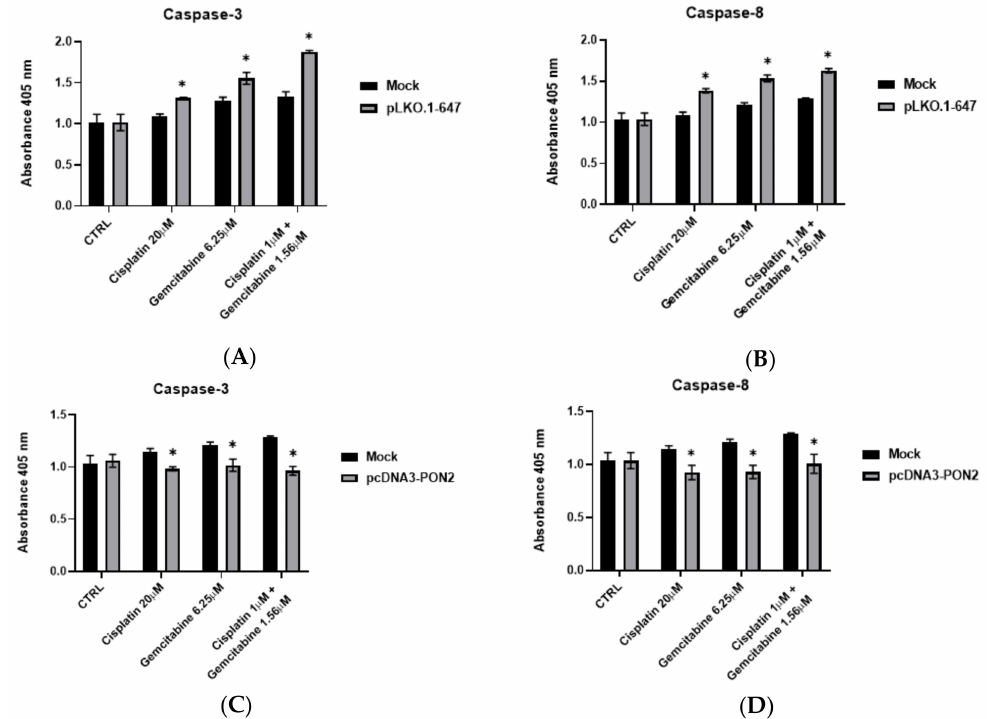
Figure 6. Caspase-3 and caspase-8 activity in T24 cells treated with chemotherapeutic compounds. Apoptosis induction in PON2 downregulated (panels A and B ) and overexpressing (panels C and D ) cells was determined by evaluating the activity levels of both caspase-3 and caspase-8 after 24 h treatment with cisplatin (20 µ M), gemcitabine (6.25 µ M), or both compounds (cisplatin 1 µ M + gemcitabine 1.56 µ M). All values are expressed as the mean ± standard deviation (* p <